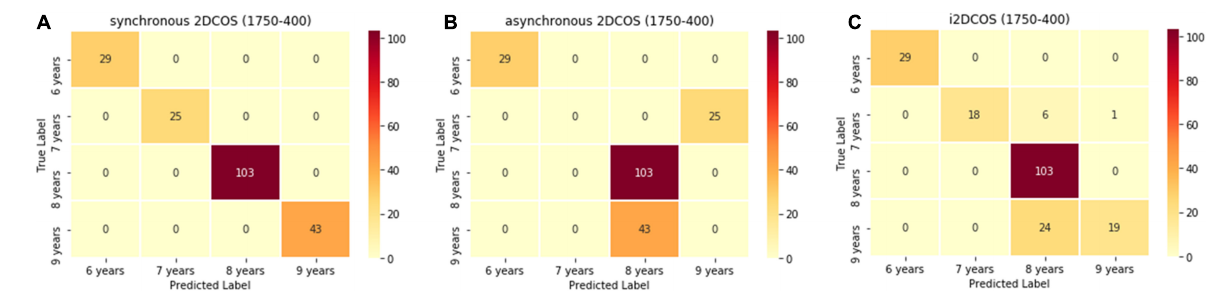
cross-peaks in the spectra of 8- and 7-year storage periods are disorganized. Figure 8C displays the i2DCOS of the four storage periods. The spectra of the 9- and 6-year storage periods have clear cross-peaks. However, the cross-peaks of the other two storage periods are not